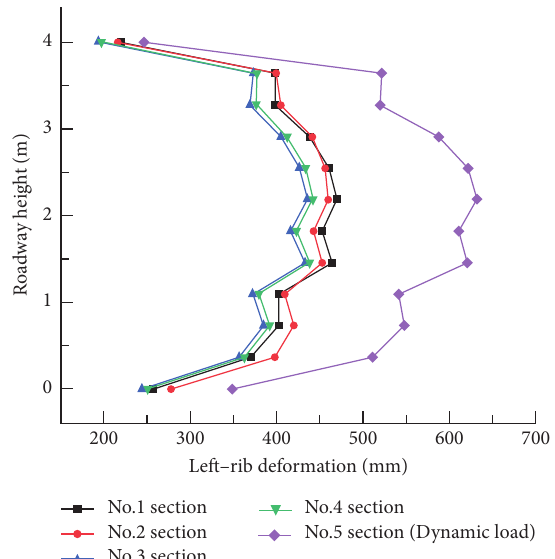
Figure 8: Evolution of left-rib displacement pattern.